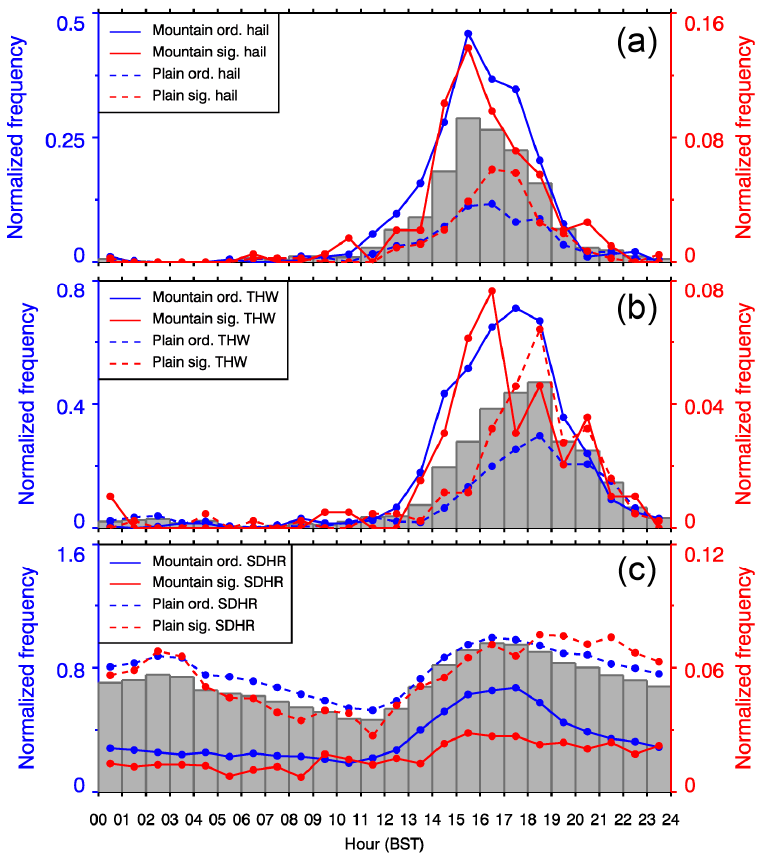
Figure 7. Same as Figure 6, but for the diurnal variation of the normalized occurrence frequencies of ( a ) hail, ( b ) THW, and ( c ) SDHR events. Grey bars represent the normalized total frequency of a particular type of event in each hour.